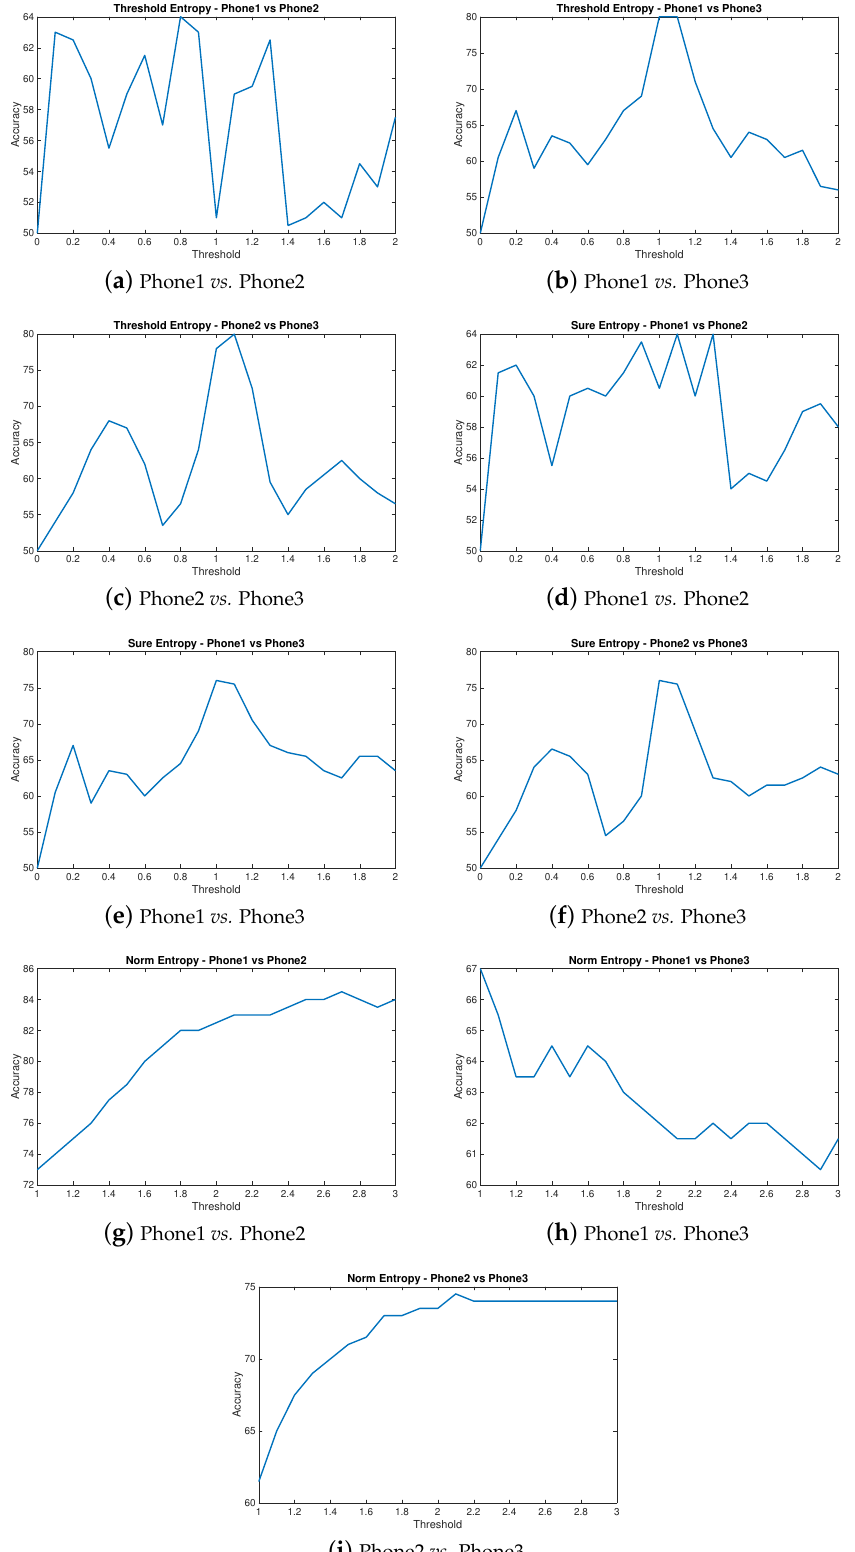
Figure 5. Threshold P Thr variation and accuracy results for Threshold Entropy , Sure Entropy and Norm Entropy features. The values that give the best average accuracies are, respectively, 1.1 (average 73.0), 1.1 (average 71.6) and 2.5 (average